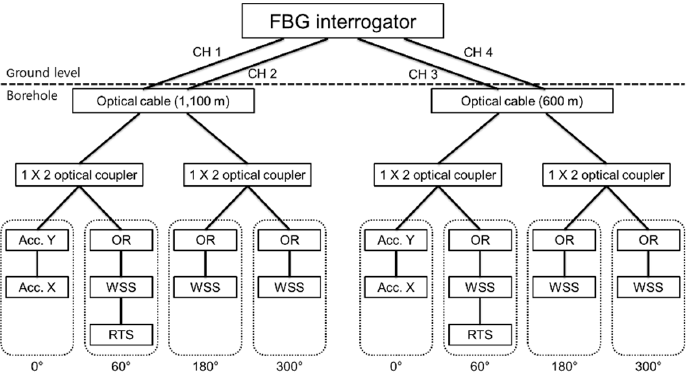
Figure 6. Fiber wiring diagram of the FBG interrogator, FBG sensor, and optical fiber cable at TENG